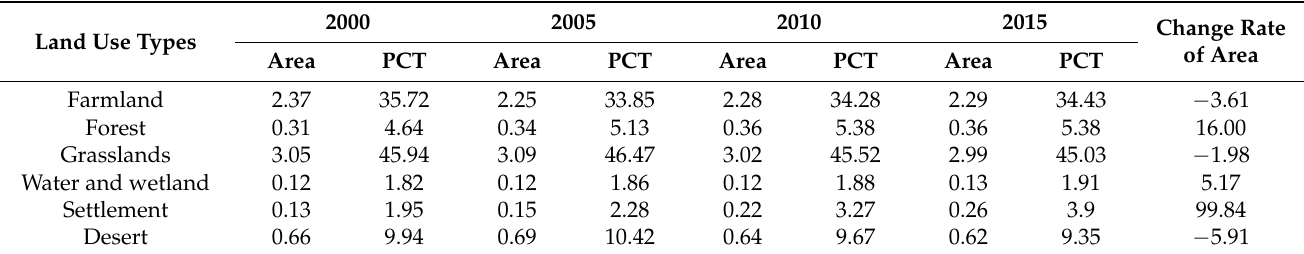
Table 2. Area and proportion of land use in Ningxia from 2000 to 2015 (10 thousand km 2 ,